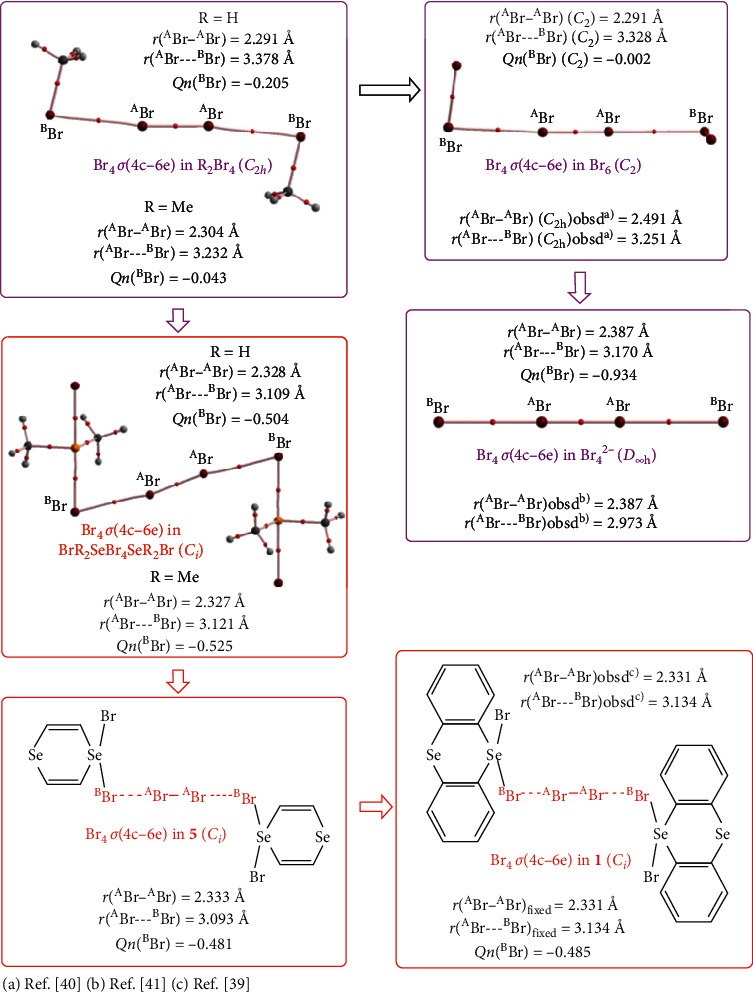
Sequence in the stabilization of Br4σ(4c–6e), starting from those in G(A) to 1 via those of G(B).